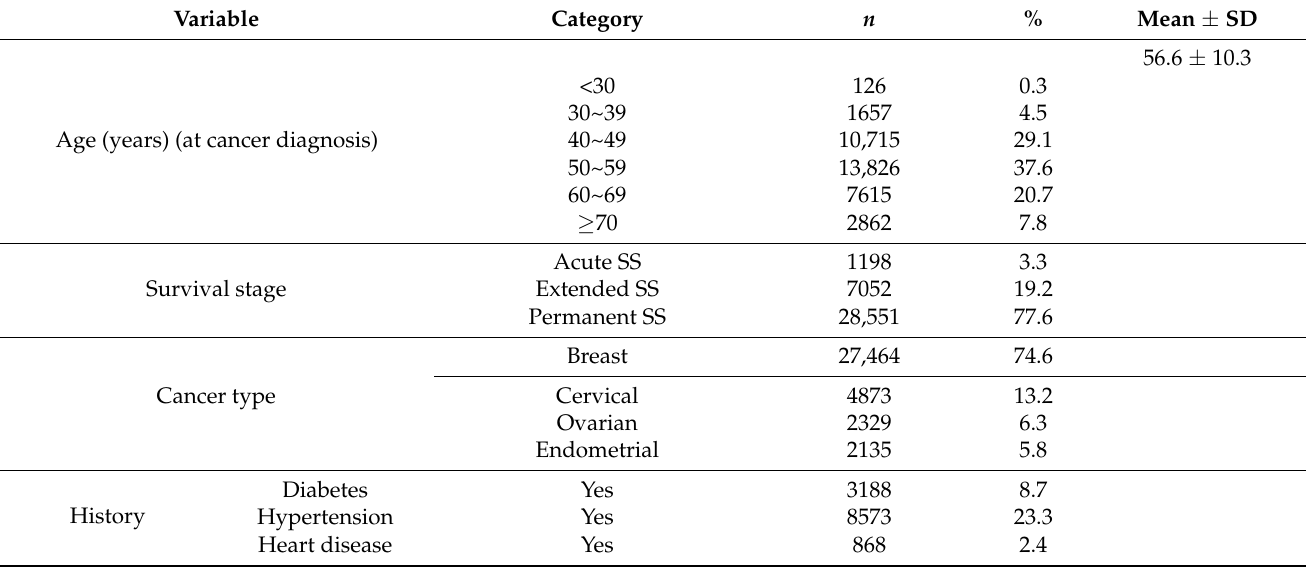
Table 1. General characteristics of study participants ( n =